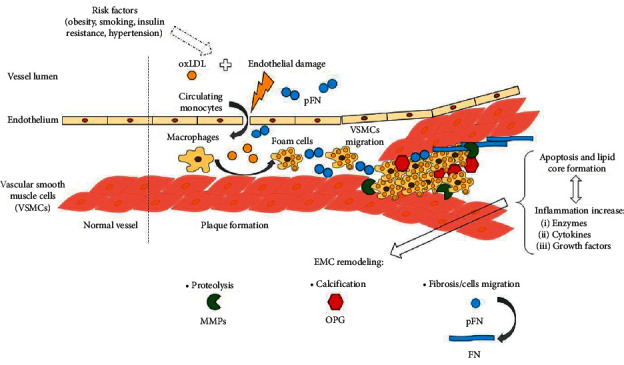
Key processes in atherosclerotic plaque formation.